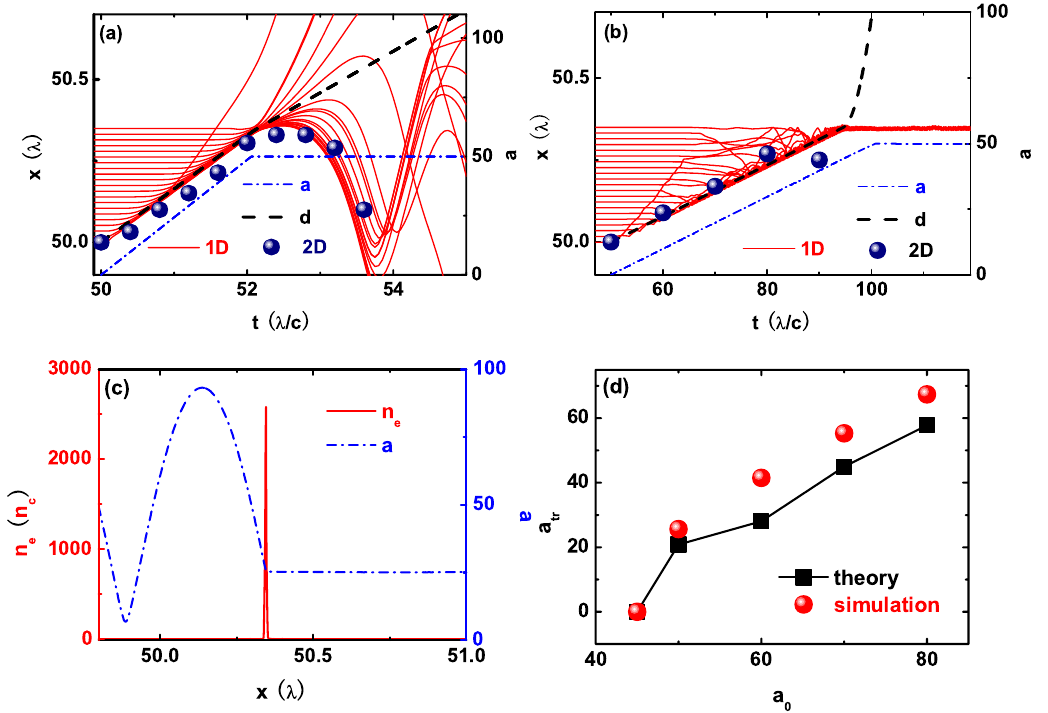
FIG. 4. CEL positions d (dashed line) and incident laser amplitudes on the CEL surface a (dash dotted line) from the analytical model and electron trajectories (solid lines) from 1D simulation and the position of CEL (solid circle) from 2D simulation for (a) a 0 =t up ¼ 29 ( a 0 ¼ 50 and t up ¼ 1 : 72 T ) and (b) a 0 =t up ¼ 1 ( a 0 ¼ 50 and t up ¼ 50 T ). Here n 0 ¼ 40 n c , l 0 ¼ 0 : 35 (cid:3) . (c) Electric field of laser pulse a (dash dotted line) and electron density n e (red solid line) at t ¼ 120 T . (d) Transmitted amplitude of the laser pulse a a tr versus 0 from theory (square) and simulation (circle). Here